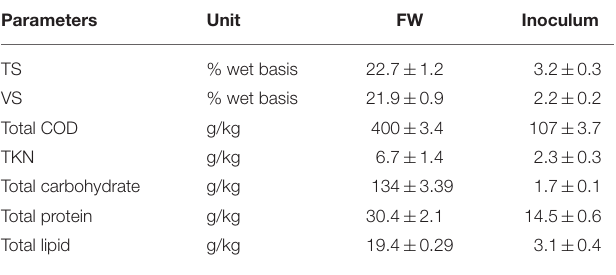
TABLE 1 | Main characteristic of FW and inoculum used in this study. Parameters Unit